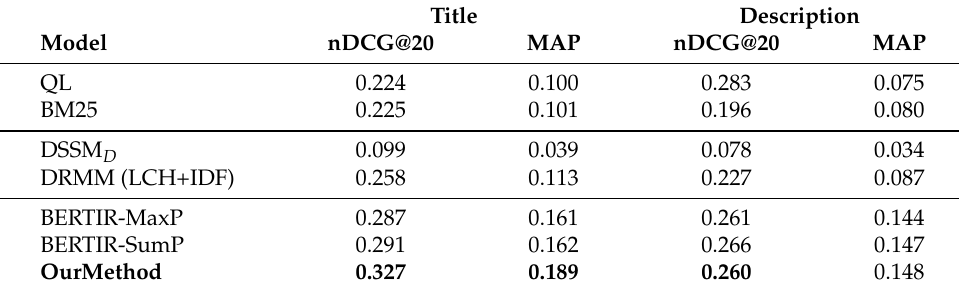
Table 5. Comparison on